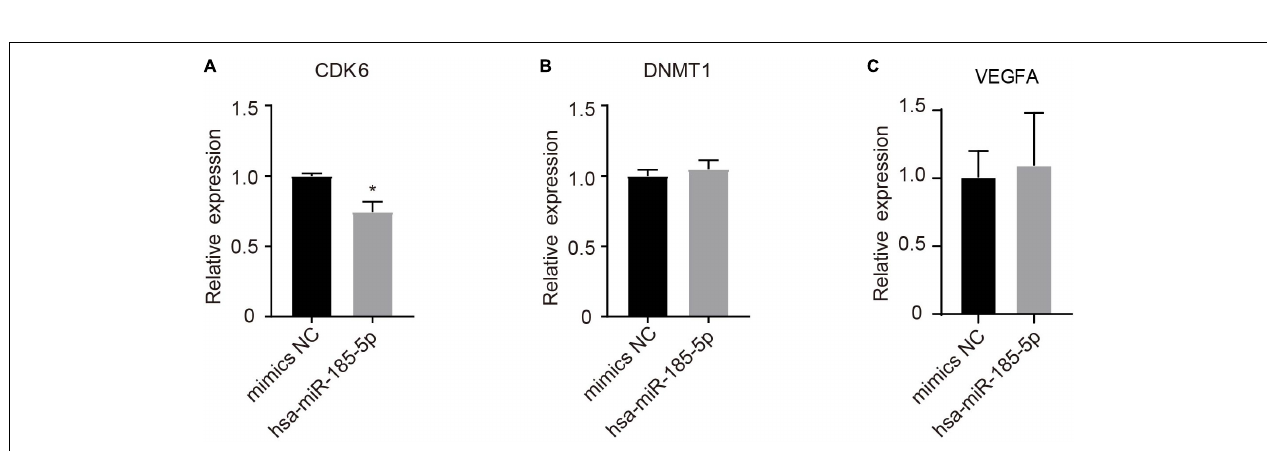
Frontiers in Cell and Developmental Biology |